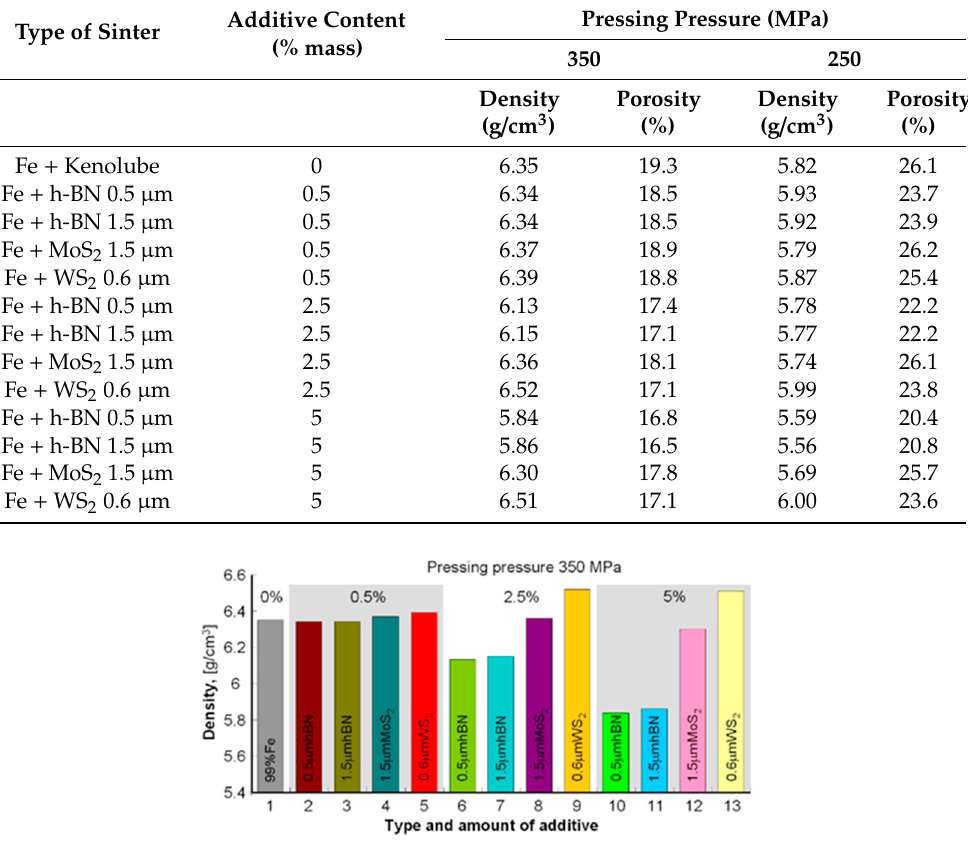
Table 3. Results of density and porosity tests.